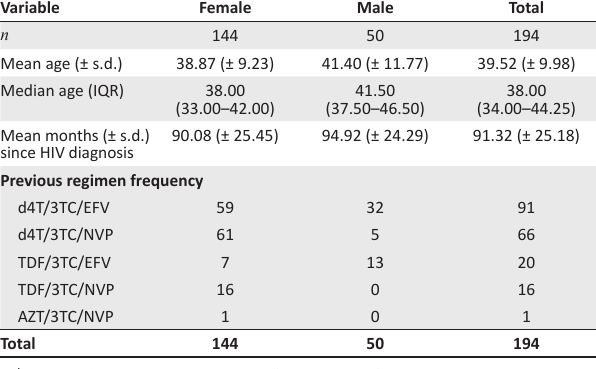
TABLE 1: Demographics and previous regimens. Variable